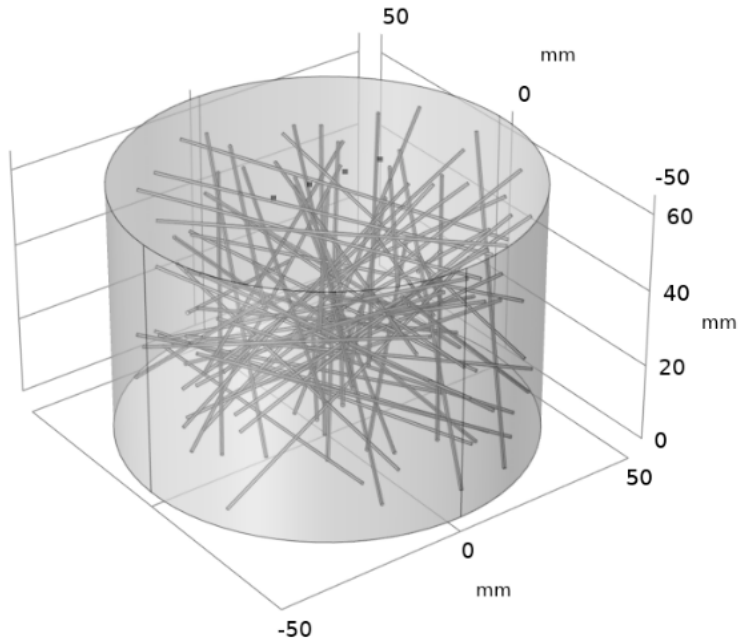
Figure 2. A sample finite element model of fiber-reinforced asphalt concrete prototype. Table 2. Dimensions of fibers.